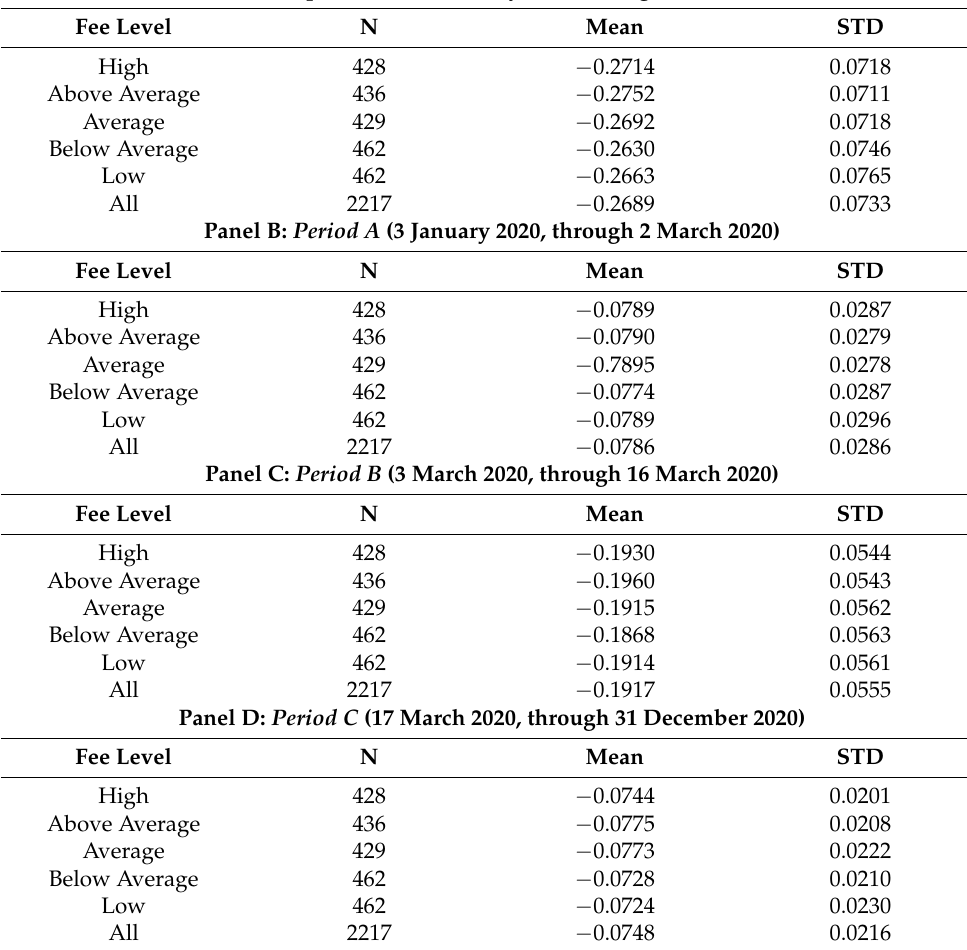
Table 7. Maximum Drawdown Statistics by Fee